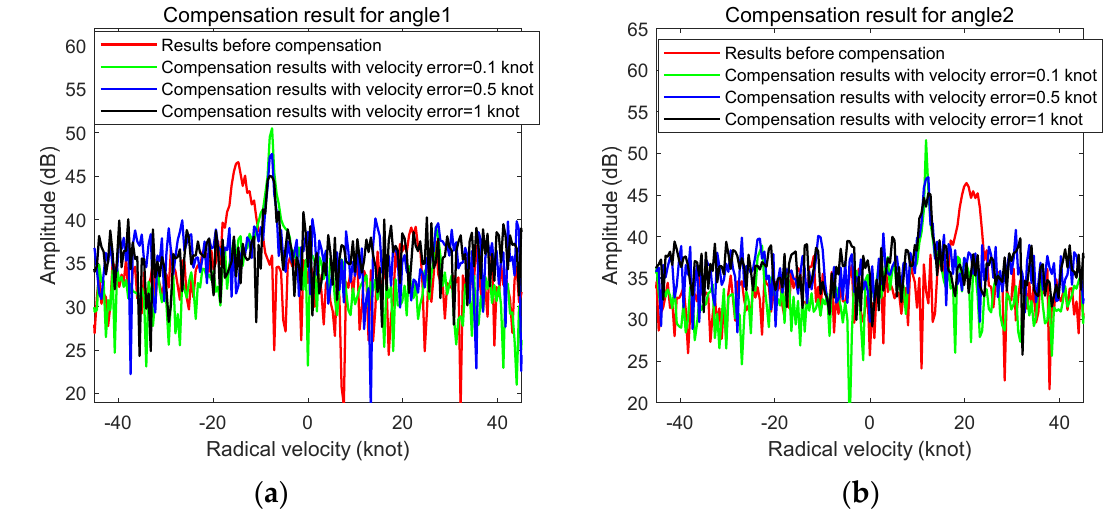
Figure 20. Motion compensation results under different velocity measurement errors: ( a ) compensation result for angle1, ( b ) compensation result for angle2.